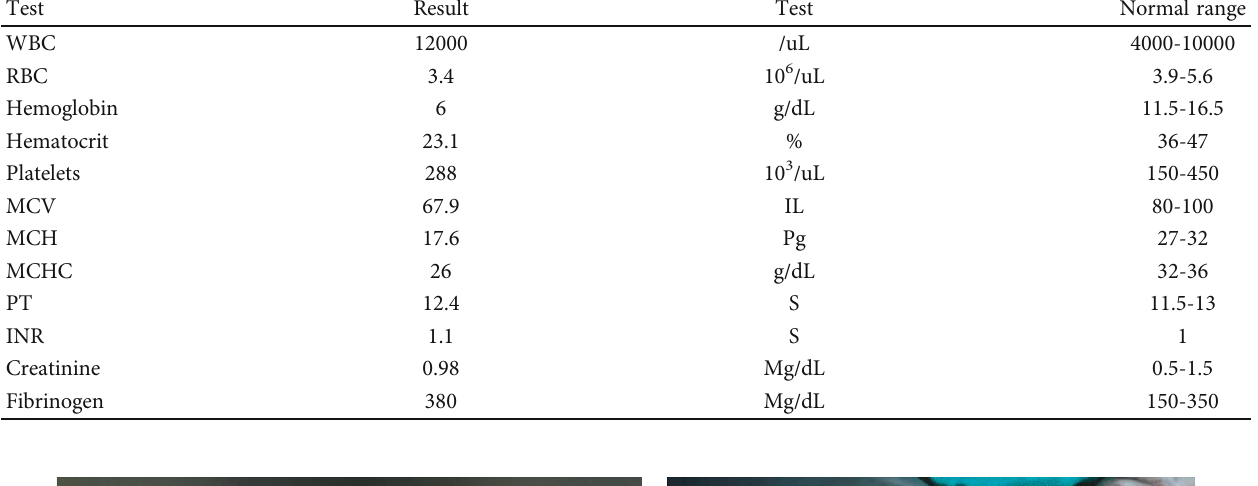
Table 1: Laboratory